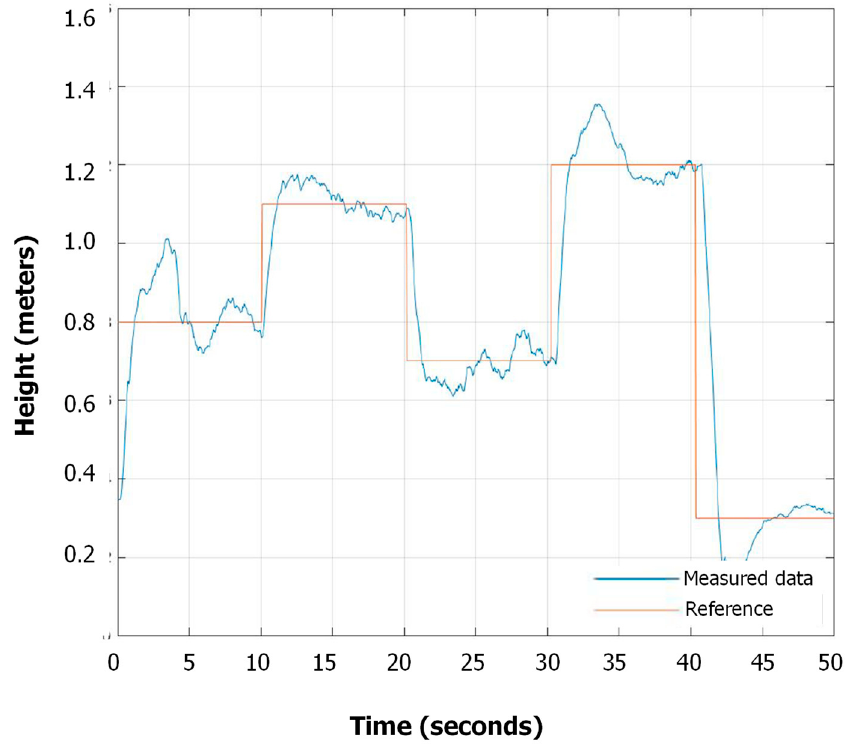
Figure 4. Experimental results when following the predefined trajectory with an additional load of 4.7 g according to the AMIGO method.